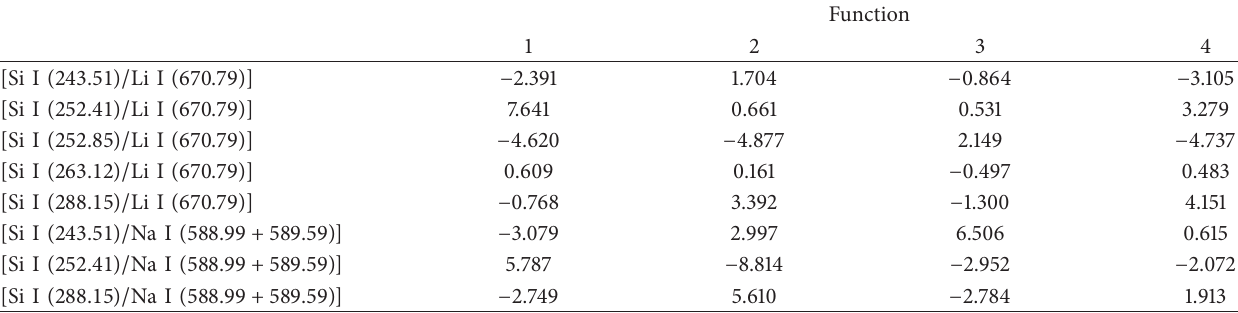
Table 3: Standardized canonical discriminant function coefficients.